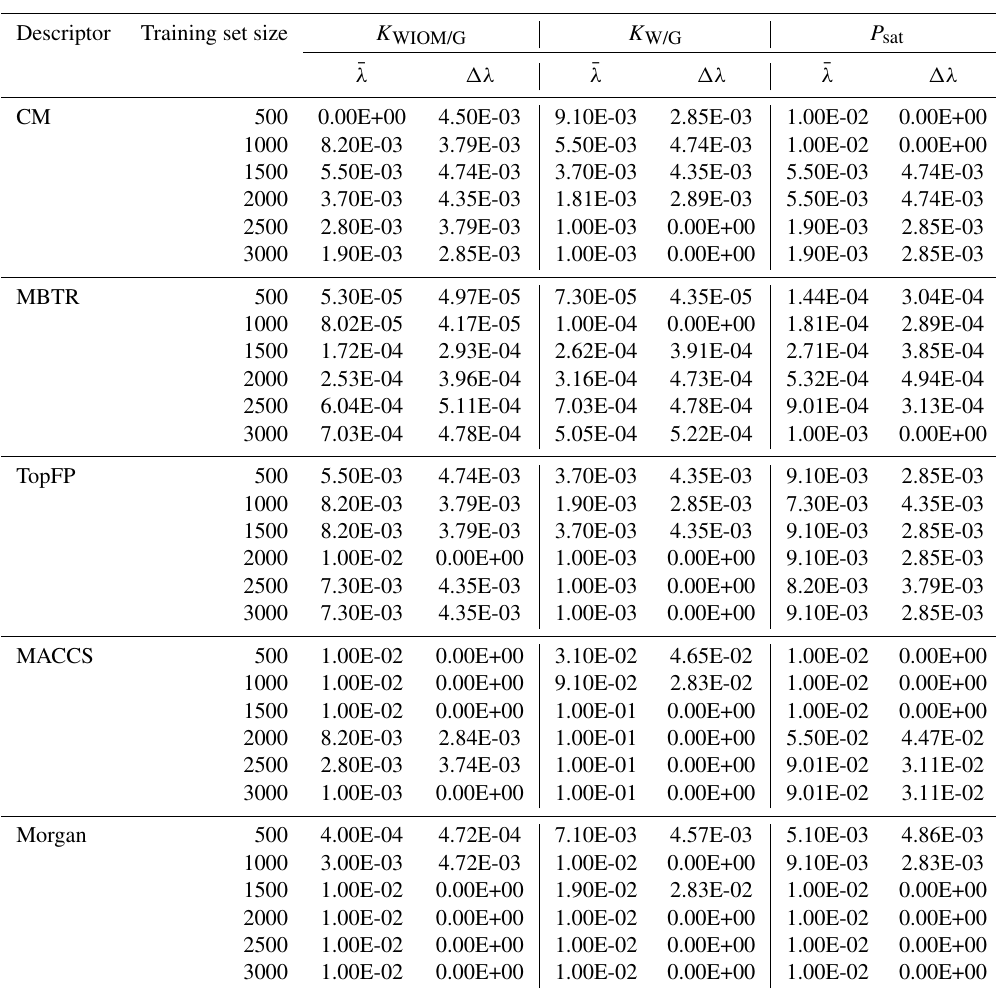
Table B1. Values of the optimal KRR hyperparameter λ obtained by cross-validation as a function of descriptor type and training set size. The procedure was repeated 10 times with re-shuffled data. Average values ( ¯ λ ) were used in further KRR models. We also report the statistical standard deviation (cid:49)λ